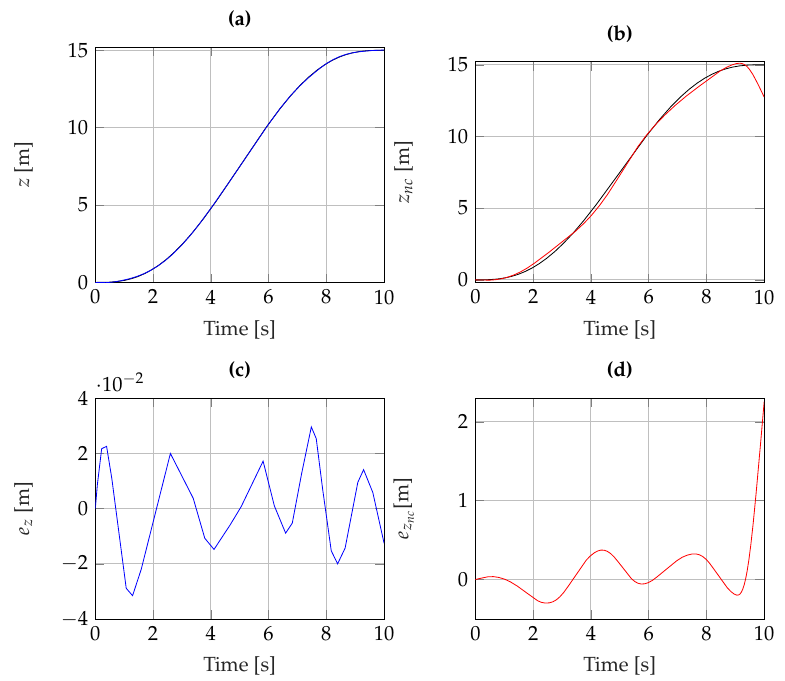
Figure 7. ( a ) Altitudinal motion of the UAV: the reference z ref (black), z with robust control (blue); ( b ) Altitudinal motion of the UAV: the reference z ref (black), z nc with non-robust control (red); ( c ) Altitudinal error motion of the UAV with robust control e z (blue); ( d ) Altitudinal error motion of the UAV with non-robust control e z (red). nc